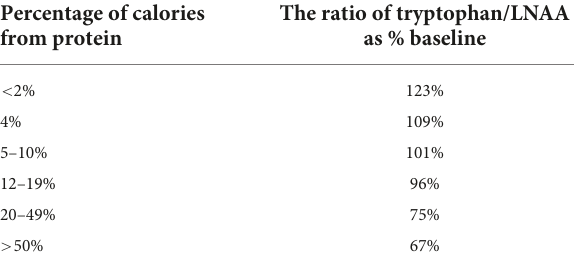
TABLE 1 The influence of protein in a meal on the ratio tryptophan/total LNAA. Percentage of calories from